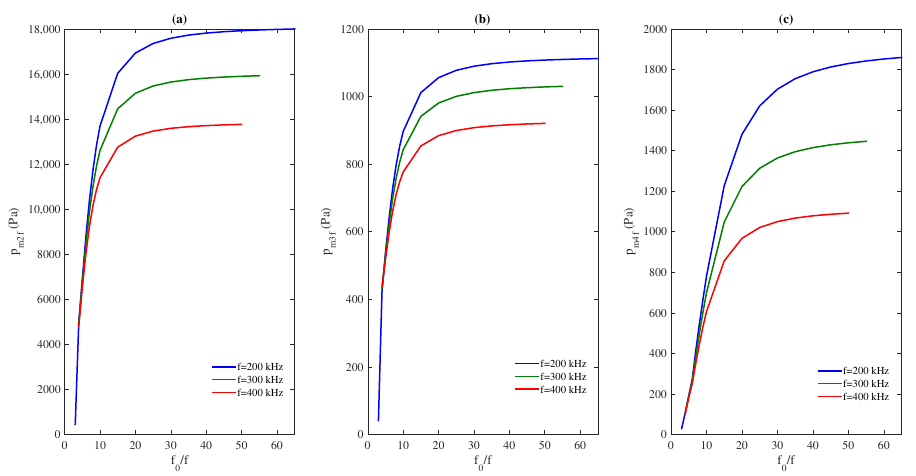
Figure 4. Maximum amplitude of 2 f ( a ), 3 f ( b ), and 4 f ( c ) in the cavity of length L = λ /4 vs. f 0 / f , for three different source frequencies f = 200 kHz (blue line), f = 300 kHz (green line), and f = 400 kHz (red line).